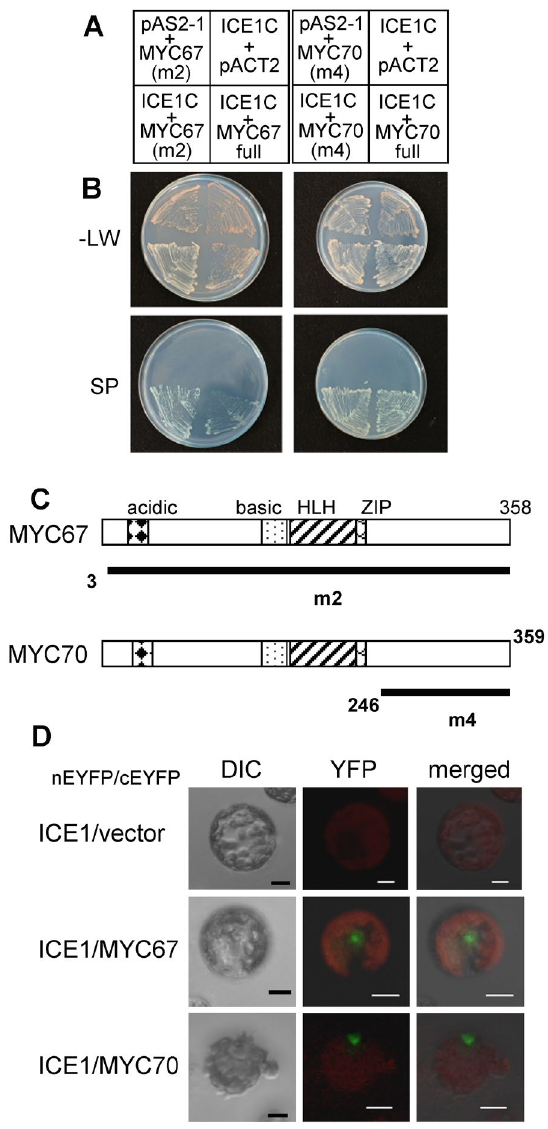
Figure 1. MYC67 and MYC70 interact with ICE1. Yeast 2-hybrid analysis. ( A ) A schematic representation of the bait (top) and prey (bottom) combinations. The yeast strains contained pAS2-ICE1-C (amino acids 267– 494) as bait together with pACT-MYC67 m2 (amino acids 3–358), pACT2-MYC67 full (amino acids 1–358), pACT2-MYC70 m4 (amino acids 246–359), or pACT2-MYC70 full (amino acids1–359) as prey. pAS2-1 and pACT2 were used as negative controls. ( B ) The yeast strains were grown on synthetic dropout (SD) plates without leucine and tryptophan ( − LW) or on selection plates (SP), which consisted of an SD plate containing X- α -gal and lacking leucine, tryptophan, histidine and adenine. ( C ) The domain structures of MYC67 and MYC70. Acidic, basic, helix-loop-helix (HLH), ZIP domains are presented. Black bars indicate the region of MYC67 m2 (amino acids 3–358) or MYC70 m4 (amino acids 246–359), respectively. ( D ) BiFC analysis indicated interaction between ICE1 and the MYC proteins. ICE1 was fused to N-terminal EYFP (enhanced yellow fluorescent protein), and the MYC proteins were fused to C-terminal EYFP. Each combination of constructs was transfected into Arabidopsis protoplasts. Differential interference contrast (DIC) images and the YFP fluorescence from the BiFC analysis are shown along with the merged image. The scale bar indicates 10 μ